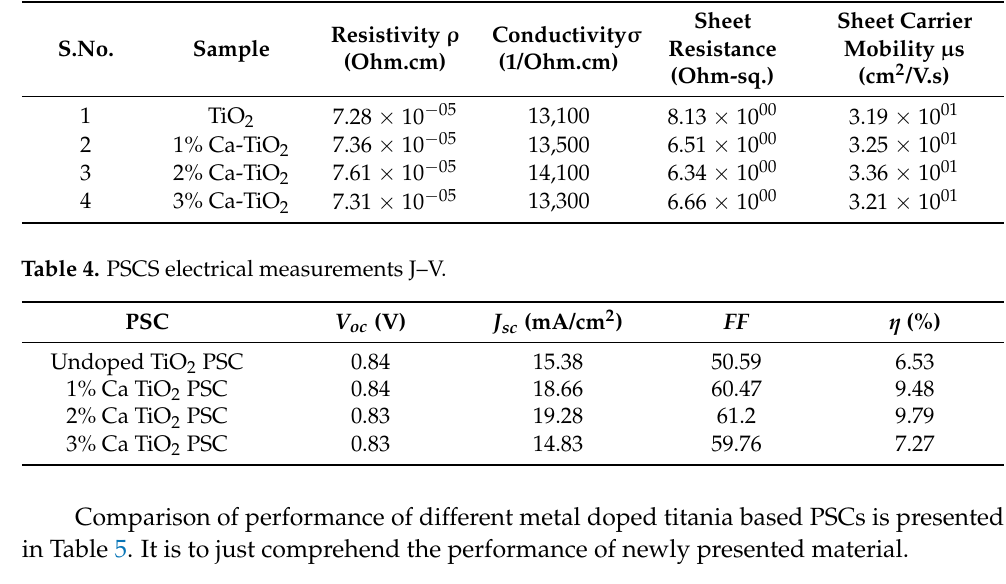
Table 3. Resistivity, conductivity, and the carrier mobility of all prepared thin films.